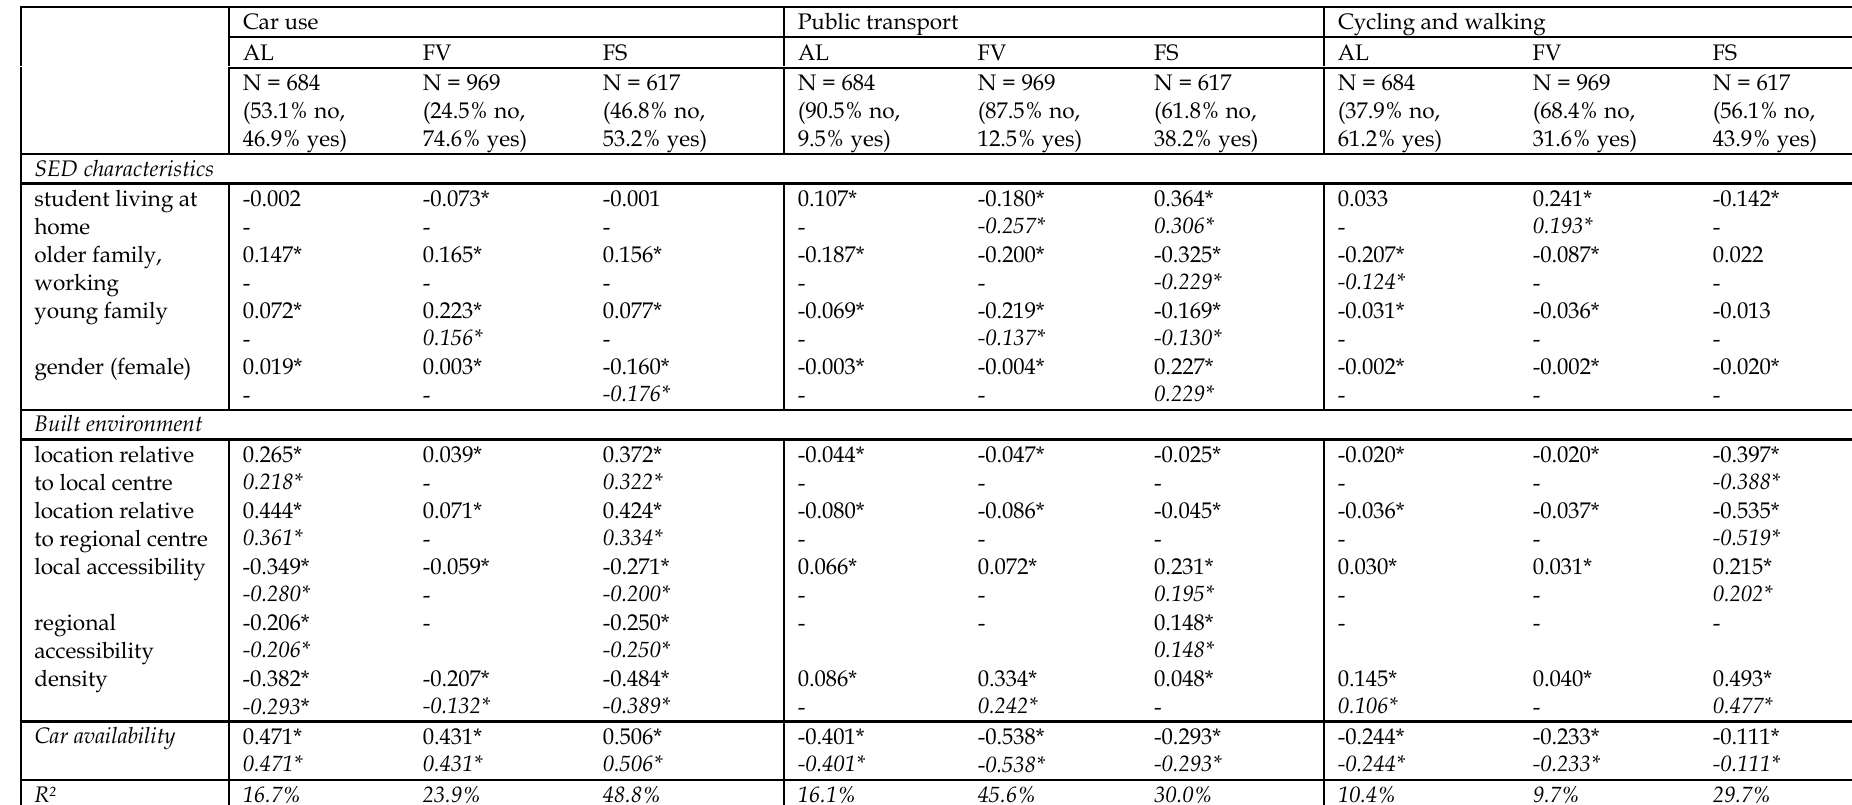
Table 6. Standardized direct and total effects on modal choice for different leisure trips while ignoring subjective